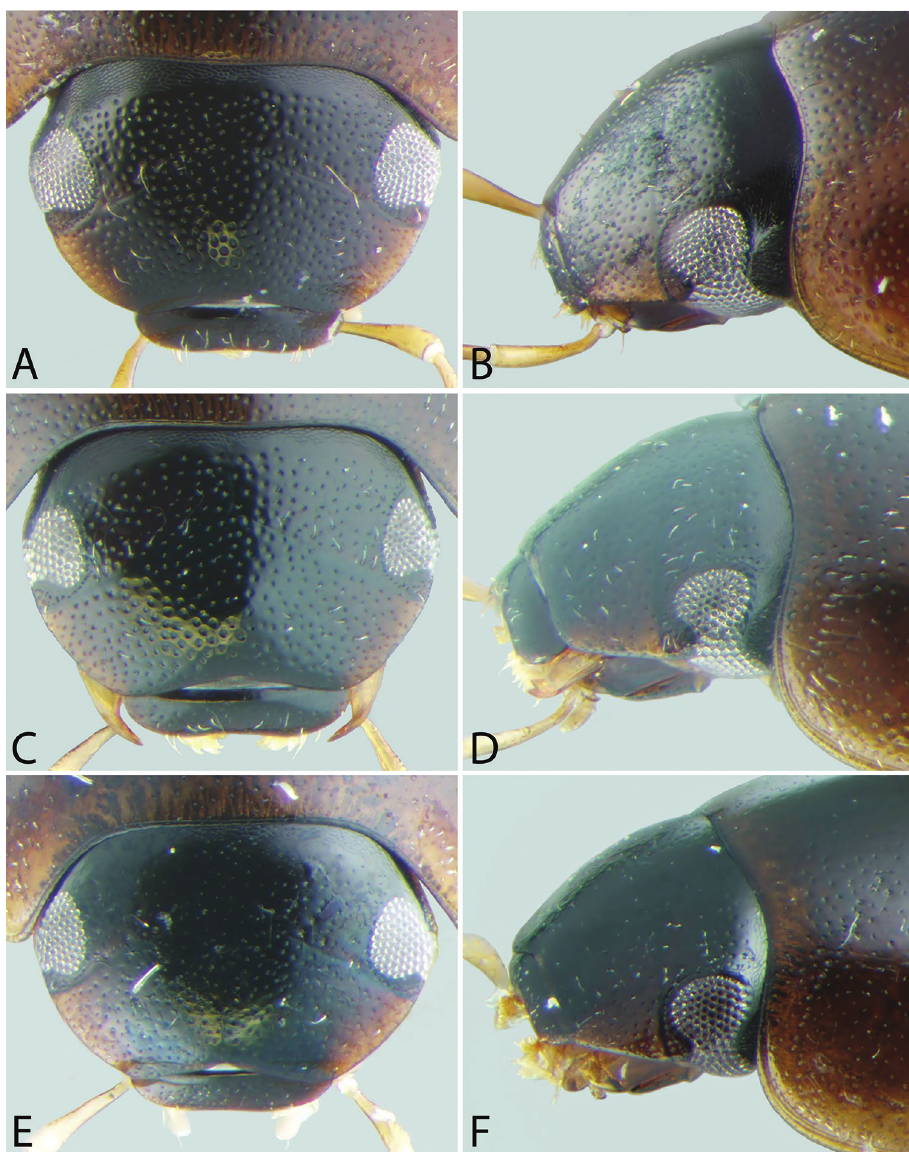
Figure 5. Front and lateral view of heads of Tobochares spp. A–B T. kusad sp. n. C–D T. striatus E–F T. sulcatus